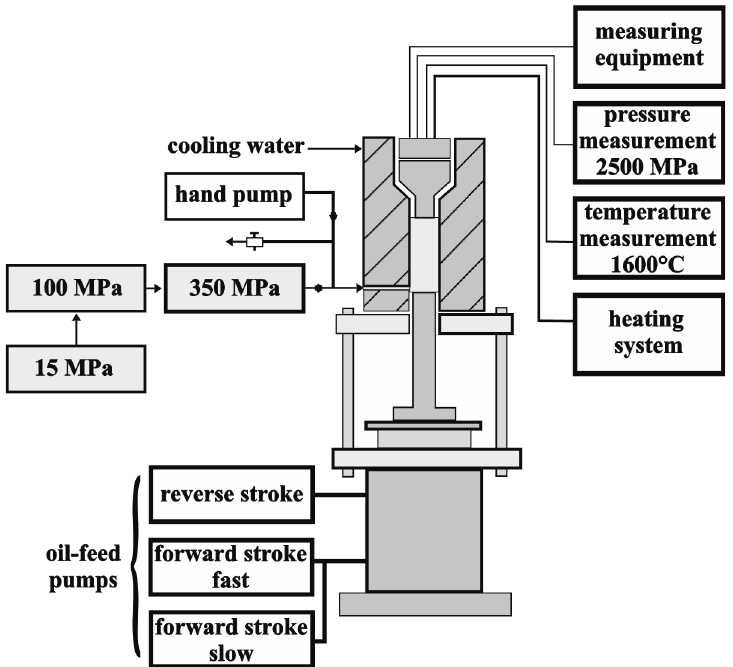
Figure 9. 2.5 GPa gas pressure vessel.